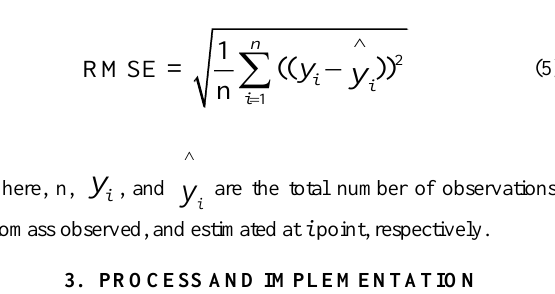
densely and regularly with a distance of one meter from each other.